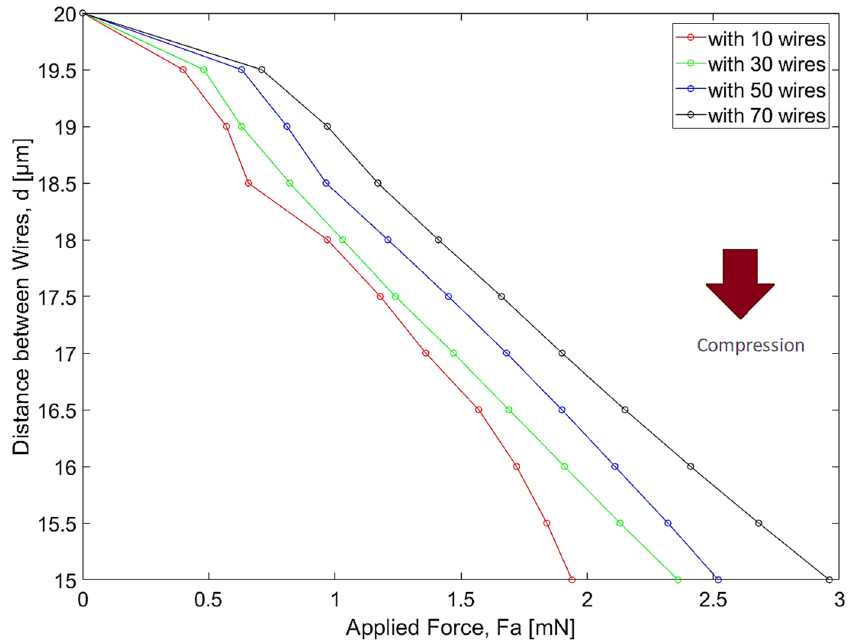
Figure 11. Reduction in the distance between wires as a function of applied force and current for 10, 30, 50 and 70 wires and a filter assembled with PTFE.